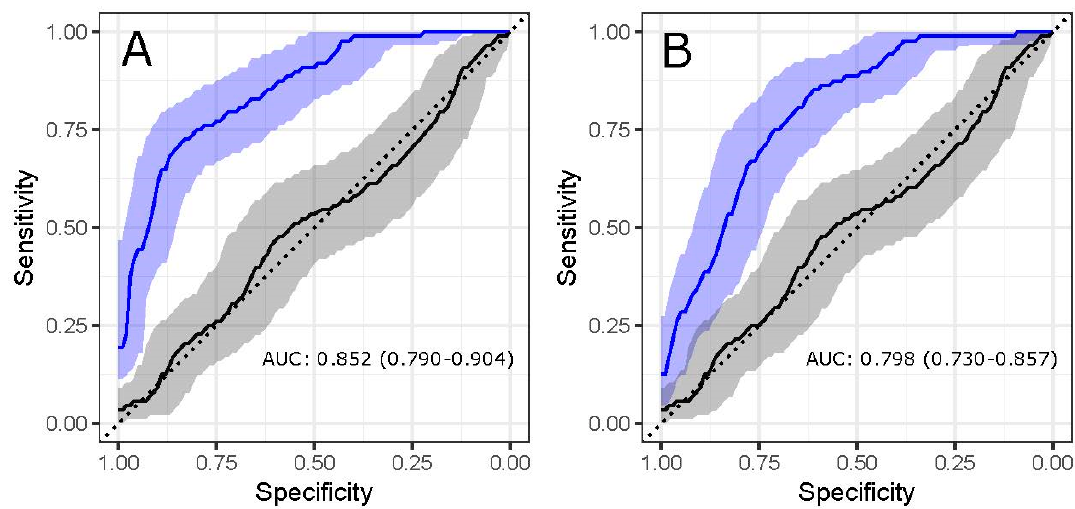
Figure 4. Classification performance of plasma protein and IgG N-glycome. ROC curves represent the performance of logistic regression model in classification of multiple sclerosis status using the total plasma protein N-glycome ( a ) and total IgG N-glycome ( b ). The blue line represents classification of disease status using the N-glycan model, while the black line represents performance of age and sex in disease status classification. Graphs are showing area under the curve (AUC) values with 95% confidence intervals.